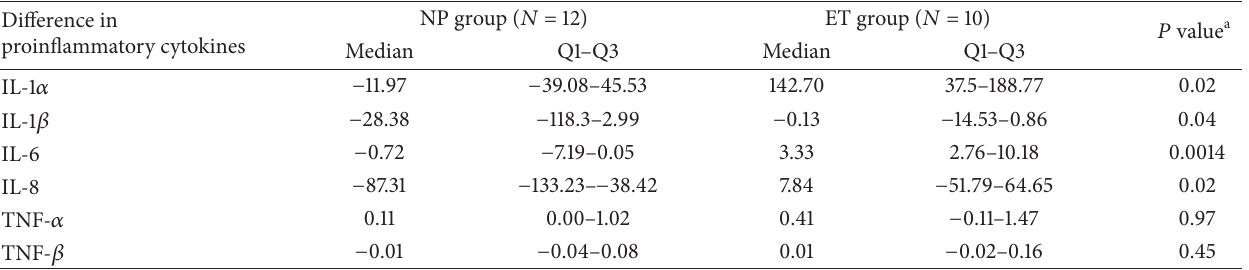
Table 5: Difference in proinflammatory cytokines between patients with and without clinical treatment progress. Difference